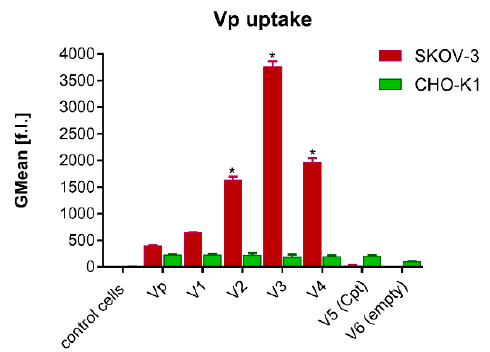
Figure 4. Influence of the nanocarrier surface on the encapsulated cargo uptake by SKOV-3 and CHO-K1 cells evaluated by flow cytometry analysis. The uptake of NCs was expressed as mean fluorescence intensity of VP in the gated cell population after 24 h incubation of cells with the loaded PLGA NCs (V1–V5), control cells (control), empty nanocarriers (V6). and free VP (Vp). See descriptions of the systems in Table 1. Pharmaceutics 2019 , 11 , x